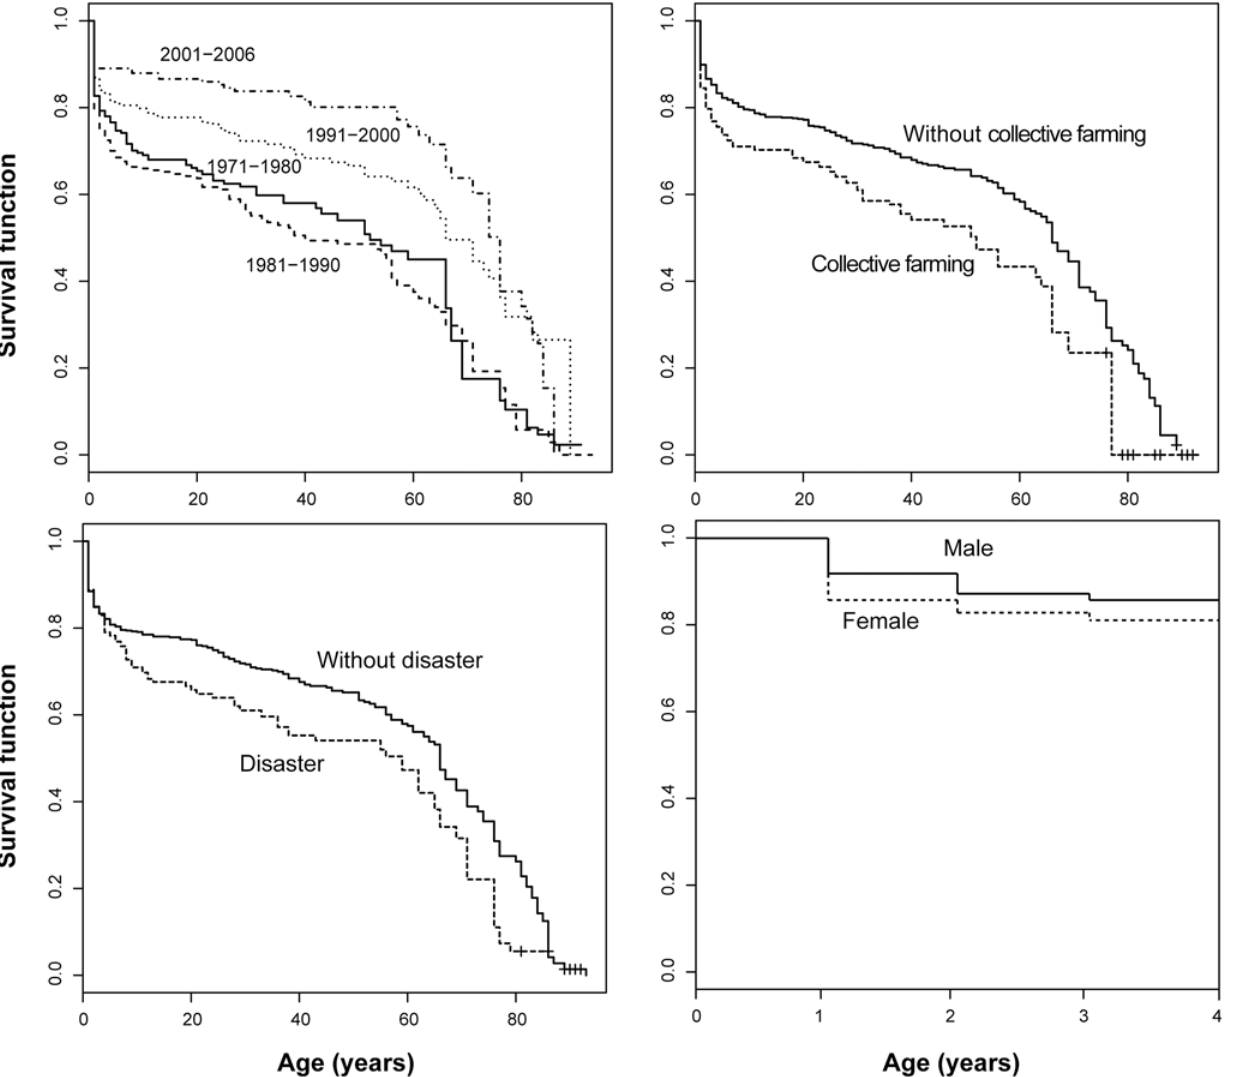
Fig 5. Kaplan-Meier (product-limit) estimates of the probability of surviving from birth to each subsequent age, Na Savang village (1971 – 2006), broken down by period (top left), whether collective farming was in force or not (top right), whether a disaster (flood or drought) occurred in a given year (bottom left), and the sex of the individual at risk (bottom right). Note that survival by sex is shown only for the first four years of